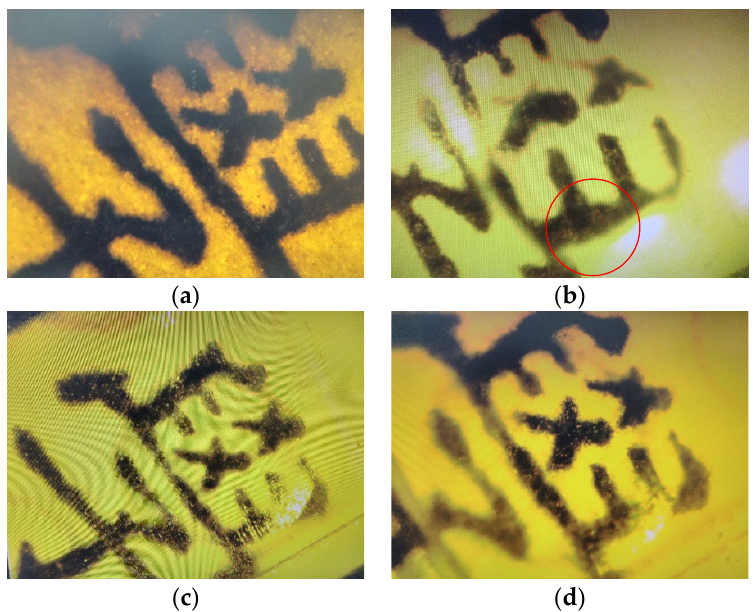
Figure 13. Image comparison. ( a ) Sample image observed on the microscope without a lens, ( b ) image formed by the microspherical lens ( R = 4 mm, k = 0) on the microscope, ( c ) image formed by the micro-aspherical lens ( R = 4 mm, k = − 0.5) on the microscope, ( d ) image formed by the microspherical lens ( R = 4 mm, k = − 1) on the microscope.